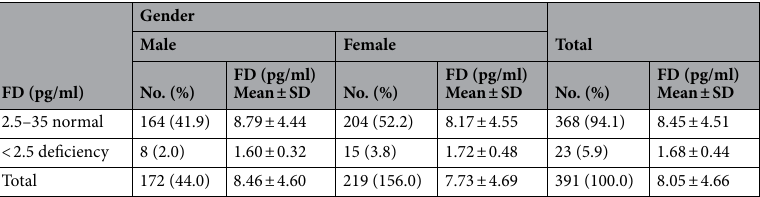
Table 4. Mean and standard deviation of Free 25-OHD level in respect to gender. P-value = 0.395.